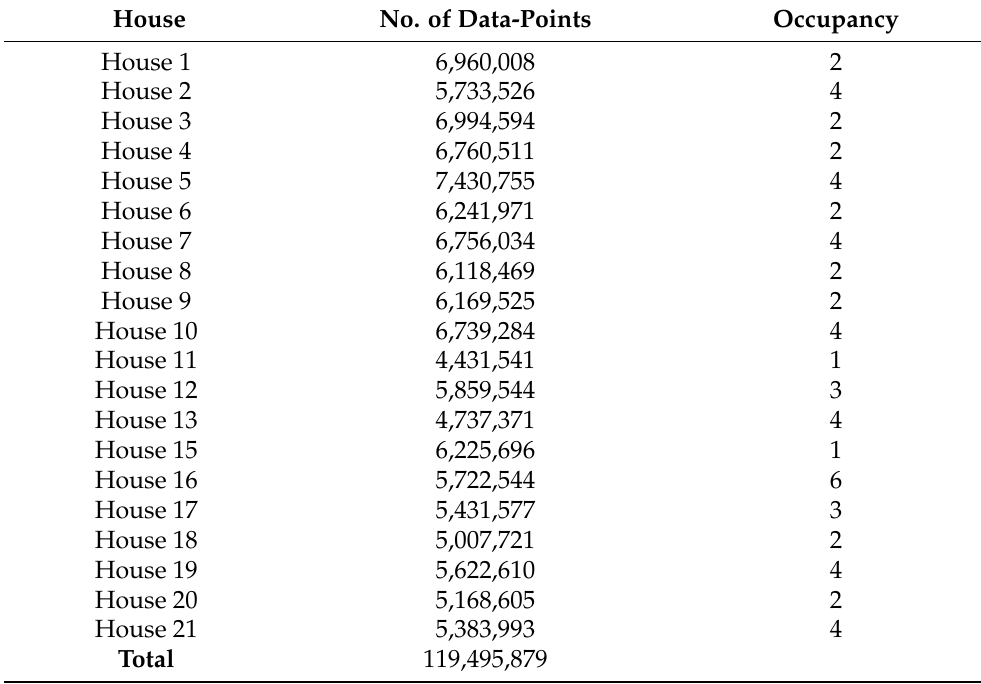
Table A1. REFIT: electrical load measurement